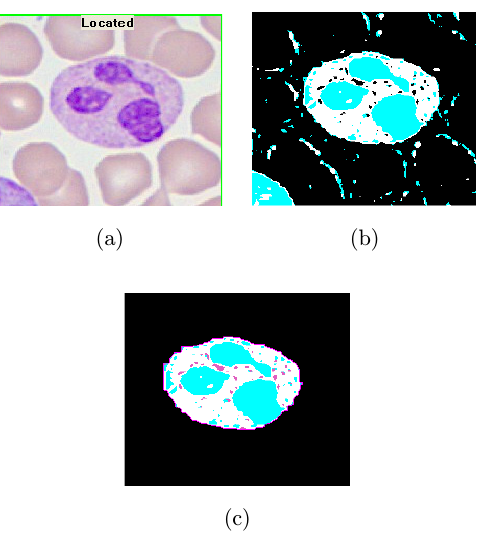
Fig. 12. (a) Located ROI, (b) segmented image by auto- threshold of Hue and saturation of HSI and (c) ¯nal result of shape ¯lter and ¯lled mask.